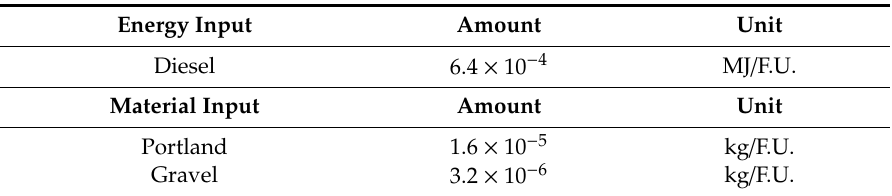
Table 7. Main material and energy input employed in the well closure phase. The cut-o ff is set 2% of the total mass, to reduce the number of inputs reported. Complete information can be found in the Supplementary Materials.